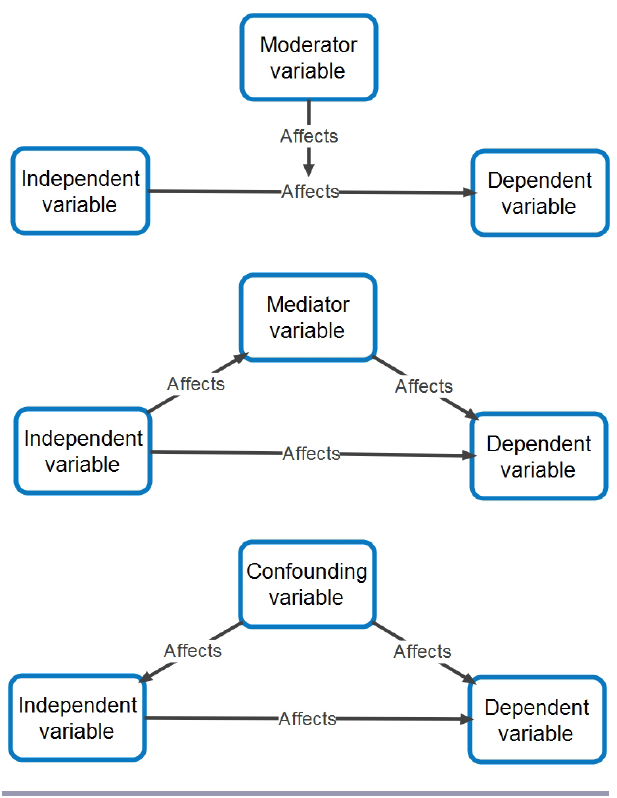
Fig. 2 . Types of variable